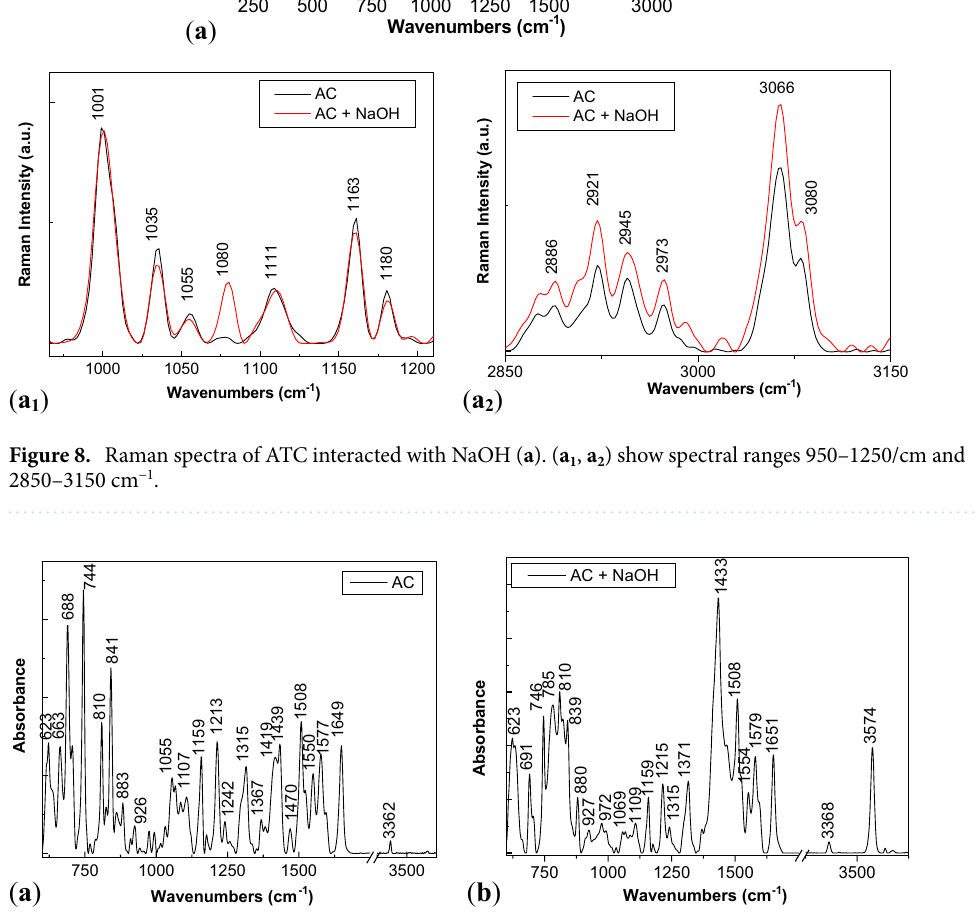
Figure 9. IR spectra of ATC before ( a ) and after interaction with NaOH ( b